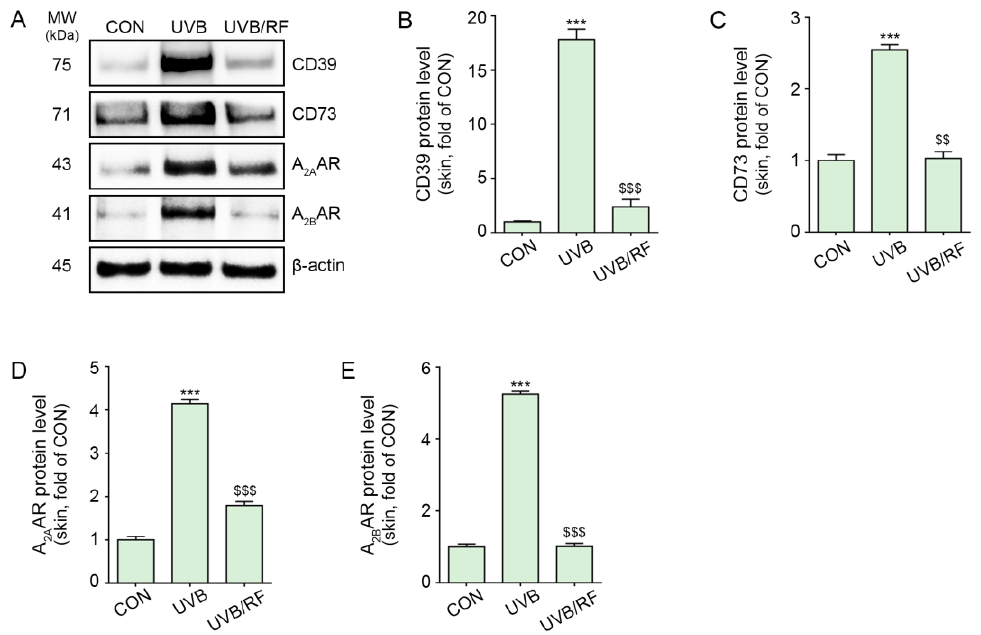
Figure 2. RF irradiation reduced CD39/CD73/A 2A AR/A 2B AR expression in UVB-exposed mouse skin. Mice were either not exposed or exposed to UVB nine times for 5 min each for 14 d (CON or UVB group), and then RF irradiation was applied (UVB/RF group). ( A ) The protein expression of CD39/CD73/A 2A AR/A 2B AR in UVB/RF-exposed mouse skin was validated using Western blot. ( B – E ) Quantitative graph for Western blot of ( A ). Data are presented as the mean ± SD of three inde- pendent experiments. ***, p < 0.001, second bar vs. first bar; $$, p < 0.01; $$$, p < 0.001, third bar vs. second bar (Mann – Whitney U test). A 2A AR, A 2A adenosine receptor; A 2B AR, A 2B adenosine receptor;